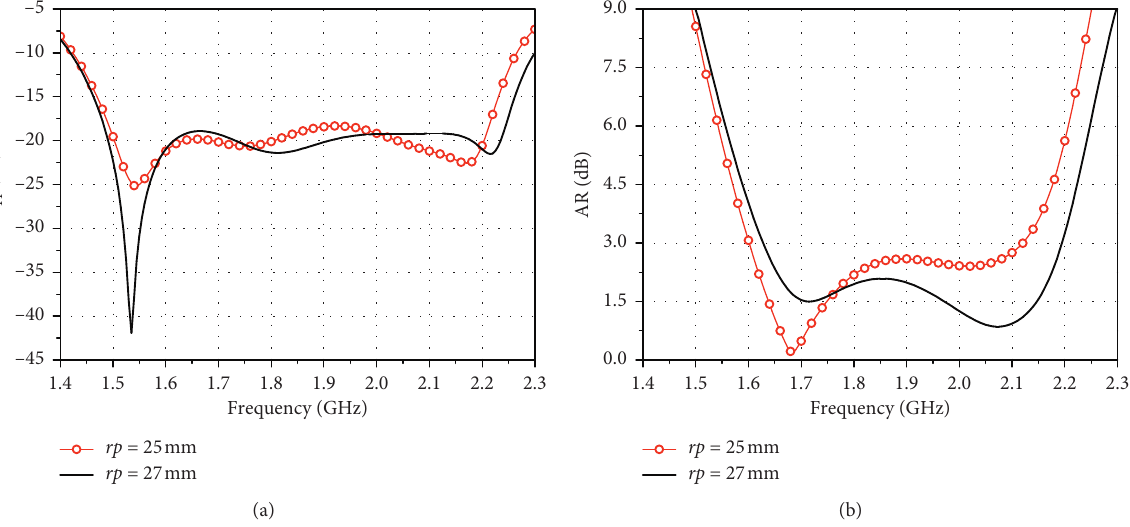
Figure 8: Effects of the radius rp on (a) S